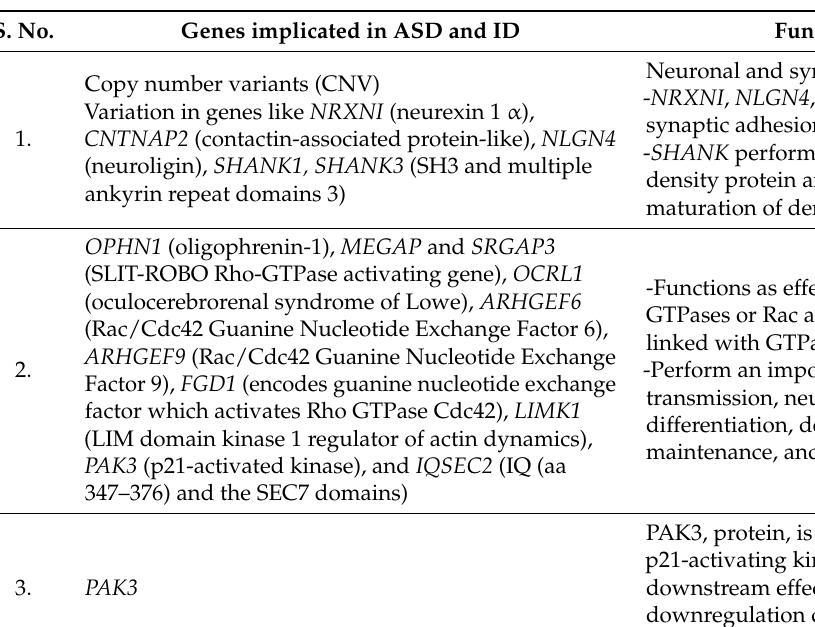
Table 2. List of genes implicated in ASD and ID